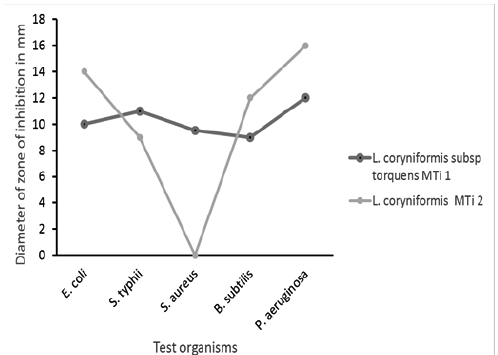
Fig. 1. Antibacterial activity of L. coryniformis subsp. torquens MTi1 and L. coryniformis MTi2 against five test organisms